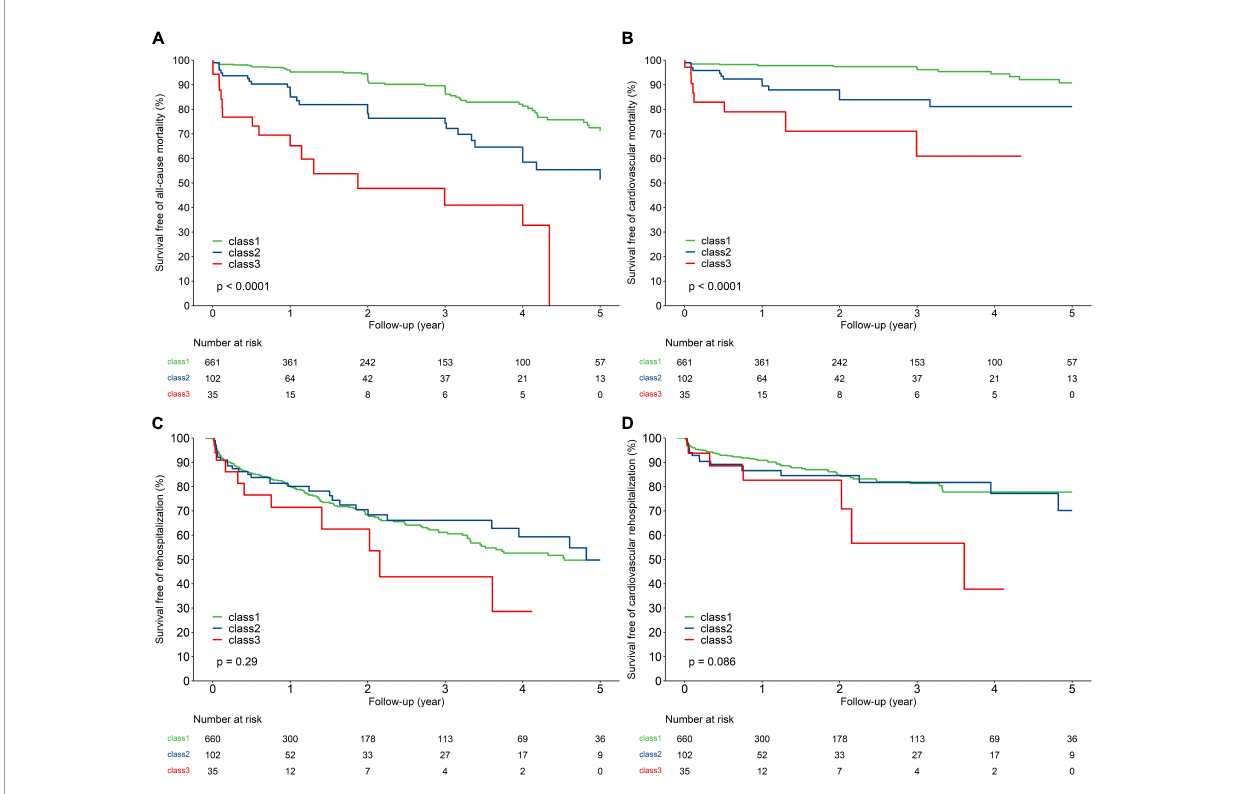
FIGURE2 Kaplan–Meier analysis for 5-year all-cause mortality (A) , cardiovascular mortality (B) , all-cause rehospitalization (C) , and cardiovascular rehospitalization (D) of the study population according to trajectories of NT-proBNP.